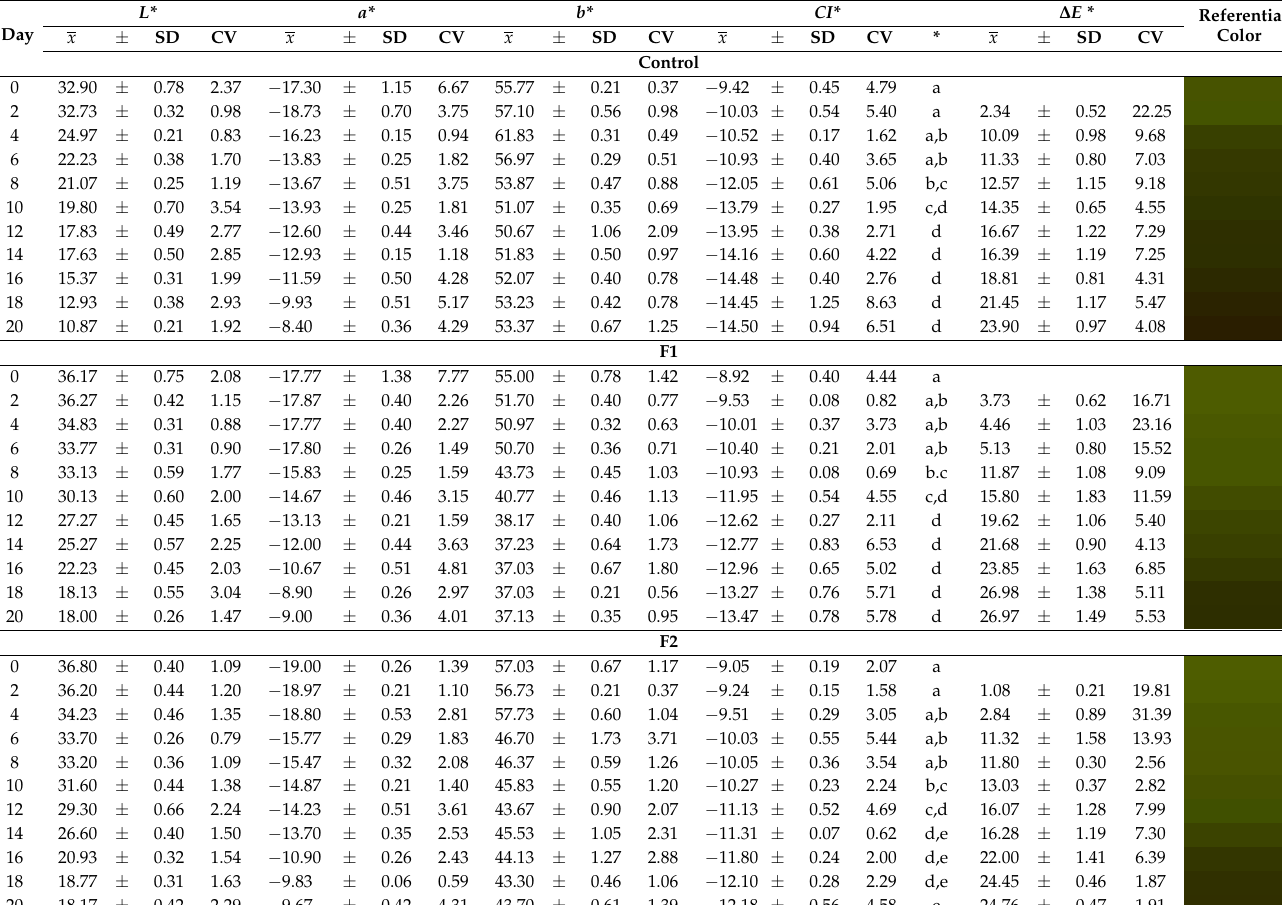
Table 7. Color of Fuerte variety